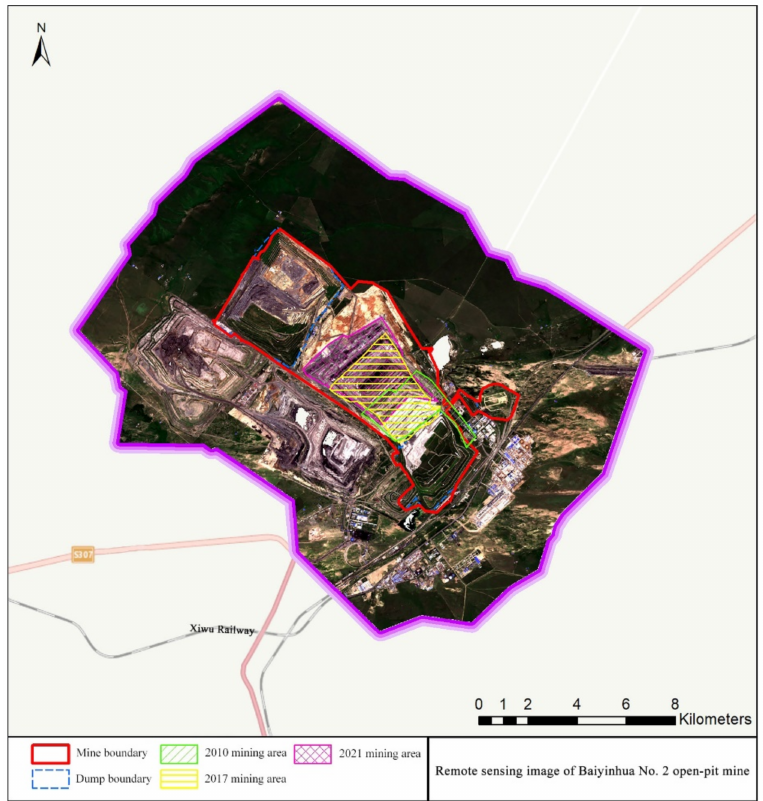
Figure 2. Remote sensing image of Baiyinhua No. 2 Open-pit